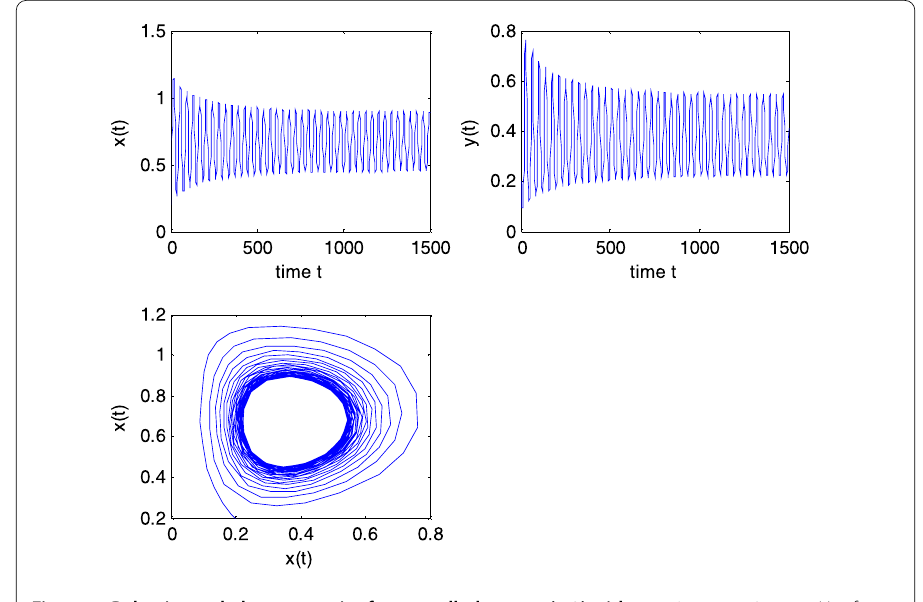
Figure 5 Behavior and phase portrait of a controlled system (1.3) with τ 1 = 0, τ 2 = 4.6 > τ 20 . Hopf bifurcation occurs from the positive equilibrium E ∗ ( x ∗ , y ∗ ) = ( 2